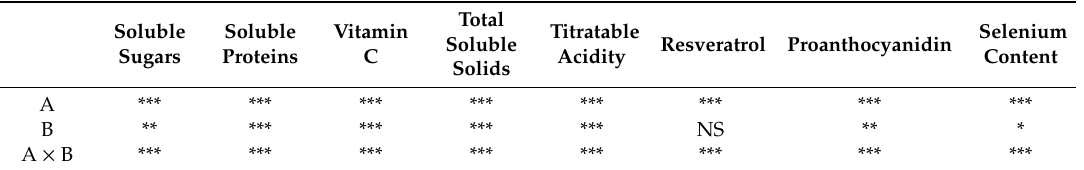
Table 3. The two-factor interaction analysis between Se fertilizer and 1-MCP of fruit quality in grape berries.